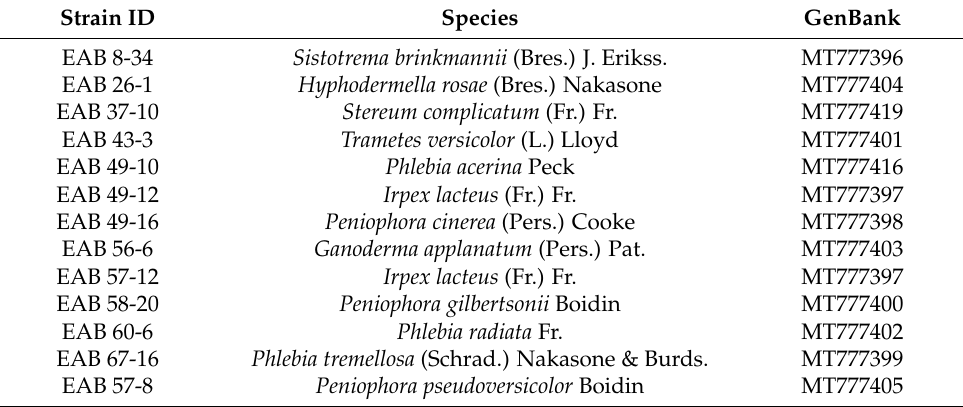
Table 1. Fungal species and strains used for decay studies and their NCBI GenBank accession